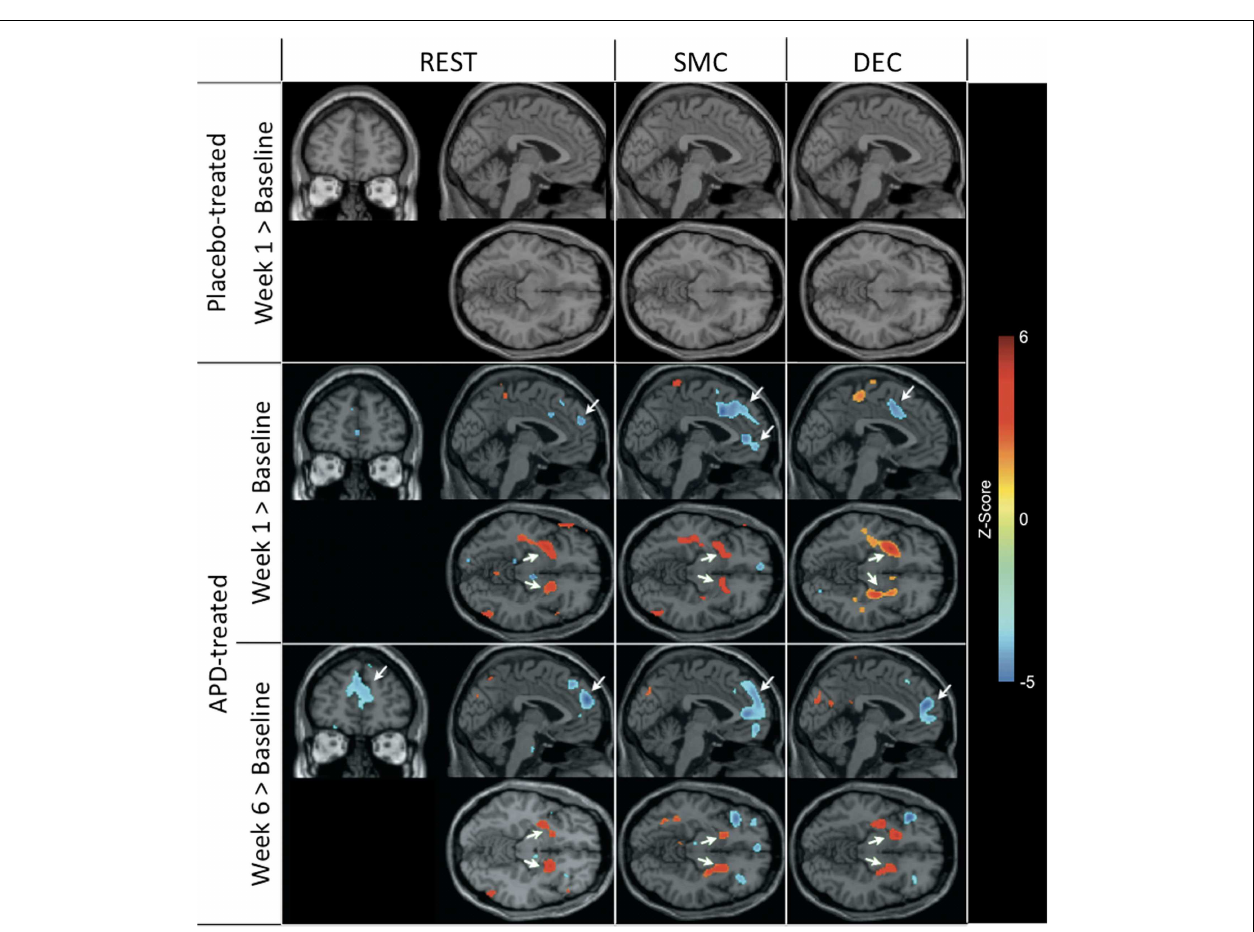
decrease in activation in medial frontal areas that shifted rostrally and dorsally between week 1 and week 6 of treatment (arrows, sagittal and coronal sections).The activation decrease was most significant during the sensory motor (SMC) and decision (DEC) task conditions. Coronal slices y = 47mm and horizontal slices z =− 10mm (Montreal Neurological Institute coordinate